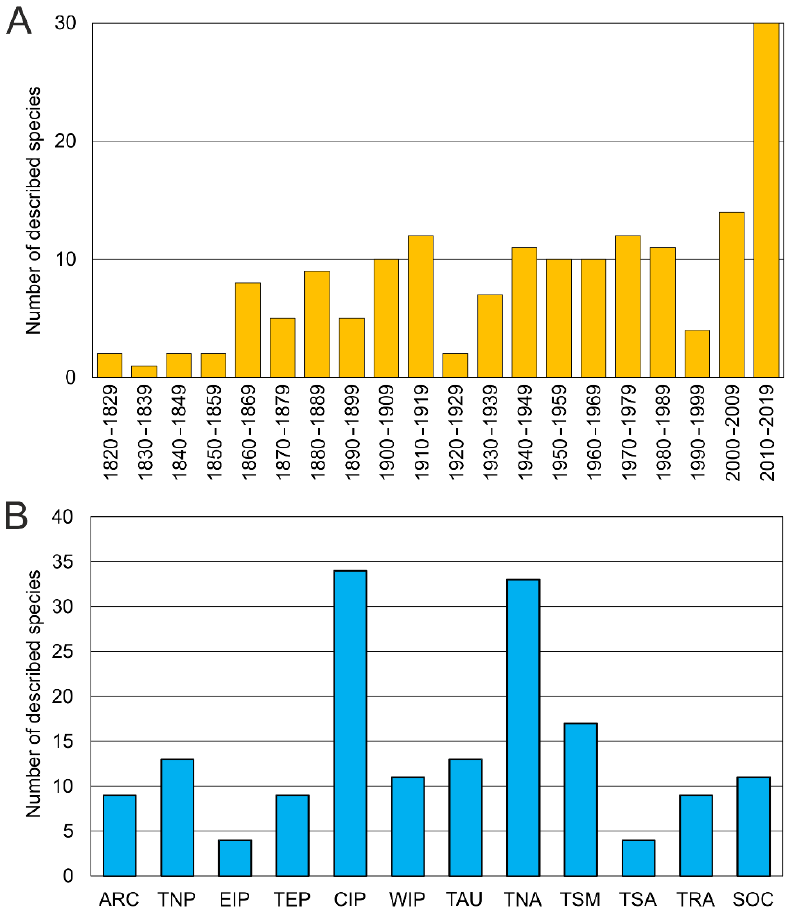
Figure 2. ( A ) number of opheliid species described per decade; ( B ) number of valid opheliid species listed under the bioregion ( sensu Spalding et al. [45]) according to type locality. Abbreviations: